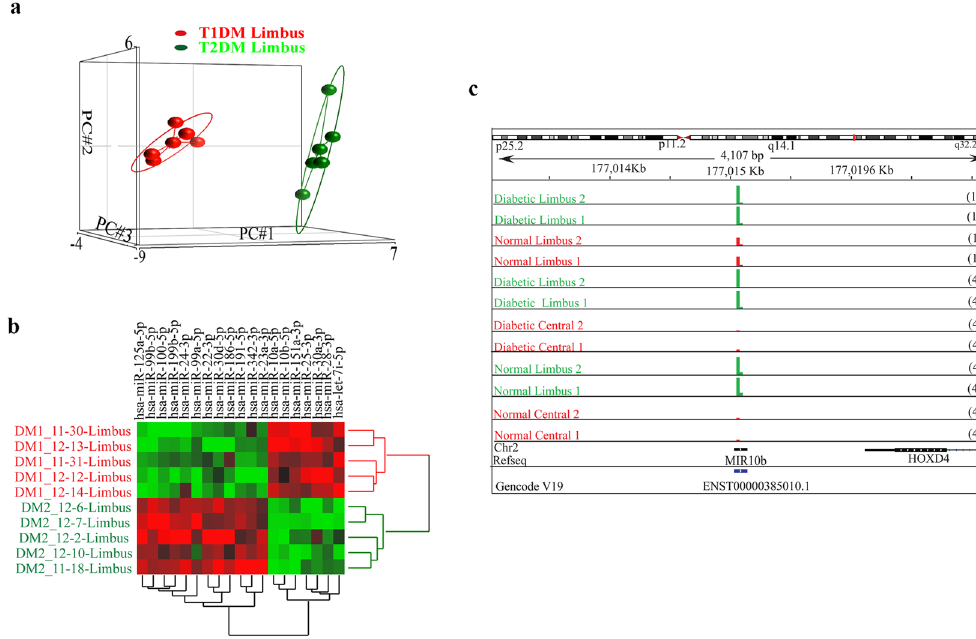
Figure 2. Differentially expressed limbal miRNAs in T1DM vs. T2DM. ( a ) PCA, and ( b ) hierarchical clustering of 19 differentially expressed gene in T1DM (IDDM) vs. T2DM (NIDDM) in limbus, FDR adjusted p < 0.05; ( c ) Genomic snapshot of miR-10b in representative two samples from each two-group